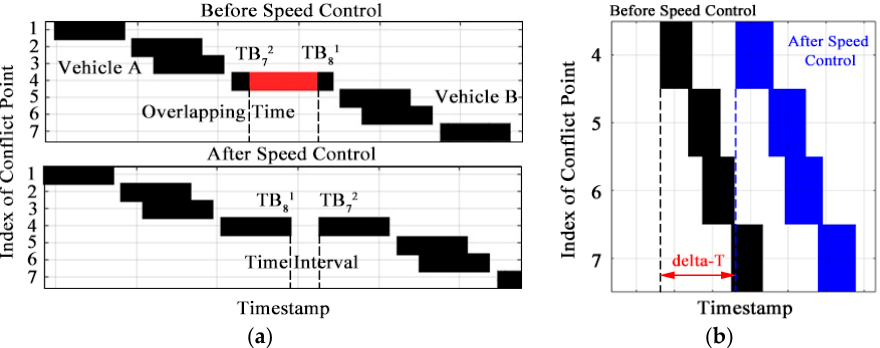
Figure 11. Diagram of speed control. ( a ) Ideal conflict resolution results of vehicles A and B; ( b ) speed control of vehicle B.